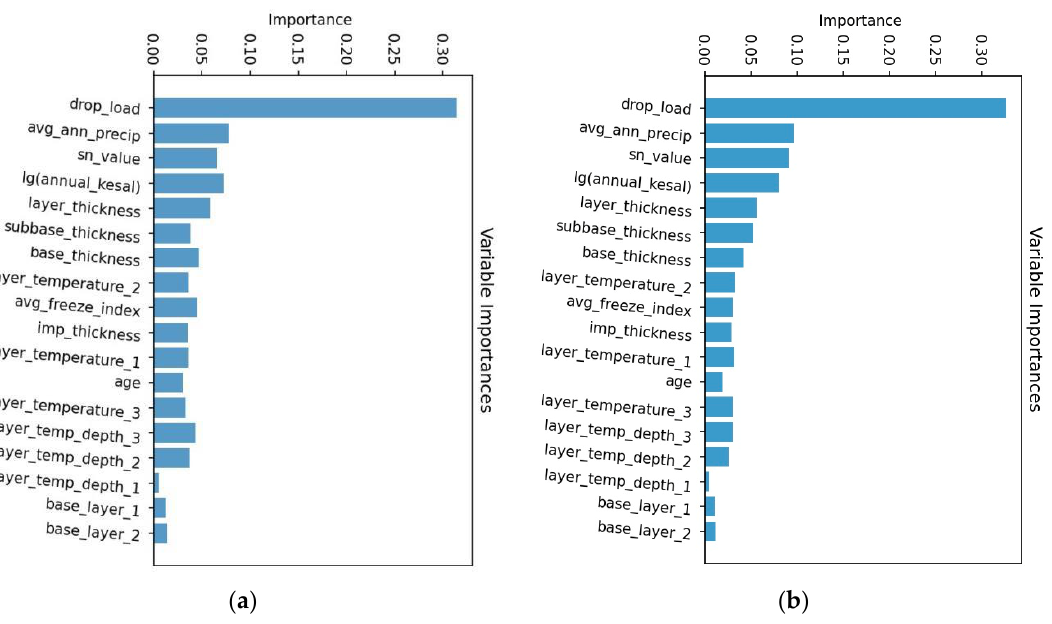
Figure 9. Feature importance obtained through RF and DF. ( a ) Feature importance of RF; ( b ) feature importance of DF level